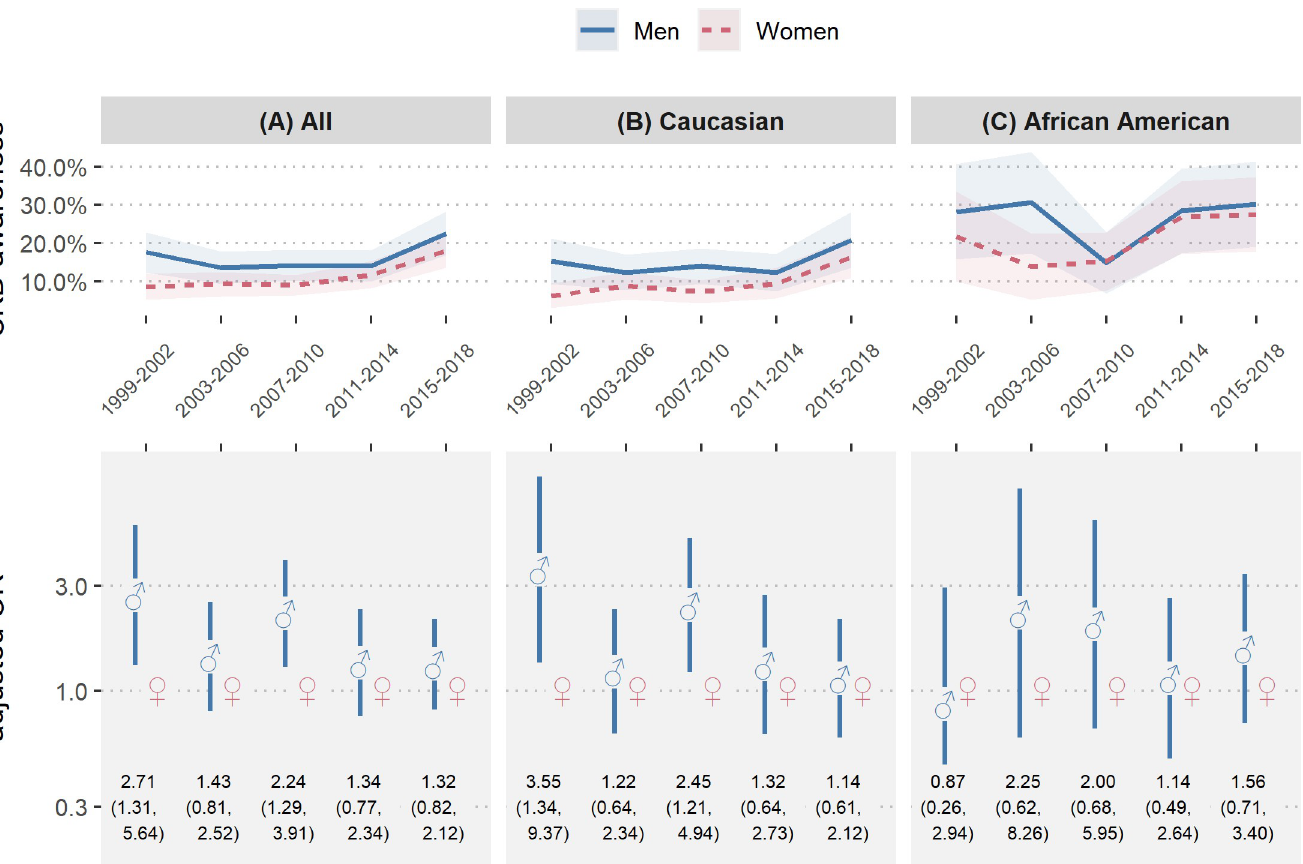
Fig 3. Chronic kidney disease awareness of men versus women over time. Chronic kidney disease (CKD) awareness of men versus women in NHANES 1999–2018 of all study participants (A), Caucasians (B) and African Americans (C); (top) Unadjusted CKD awareness over time with 95% confidence interval (bottom) CKD awareness odds ratios of men versus women by year with 95% confidence interval; Odds ratios were adjusted for CKD disease stage, age, diabetes, hypertension and BMI; Odds ratios for all study participants were further adjusted for race/ethnicity.